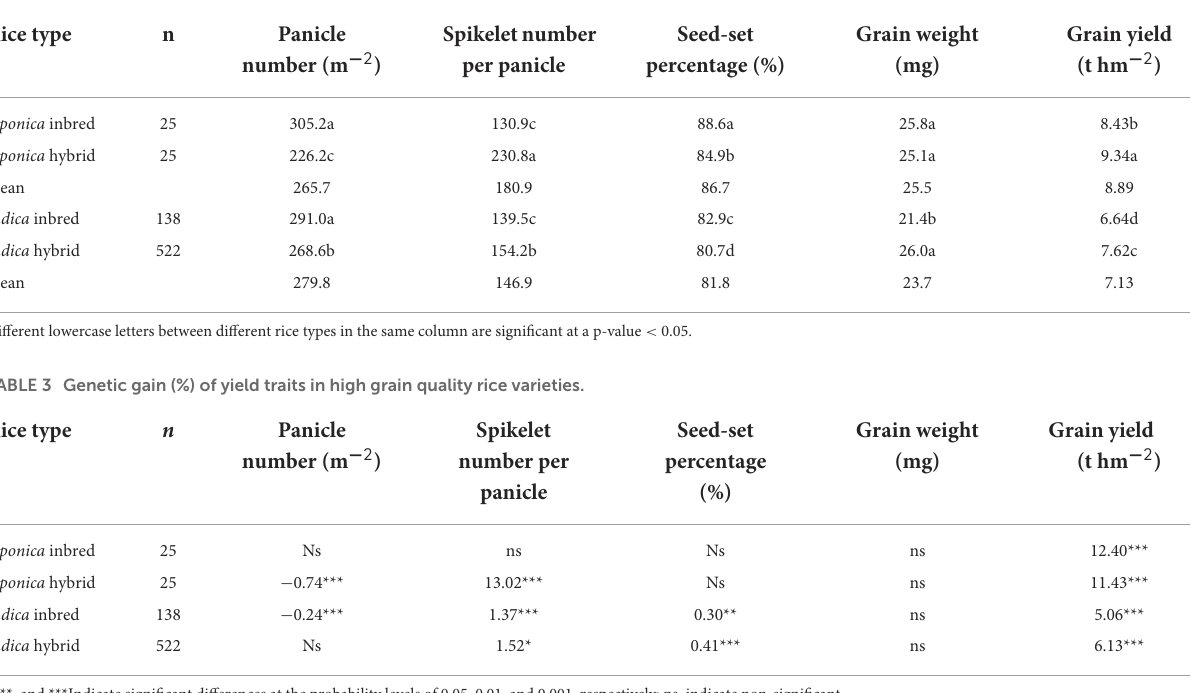
TABLE 2 Differences in the mean yield traits between japonica and indica types of high-quality rice.